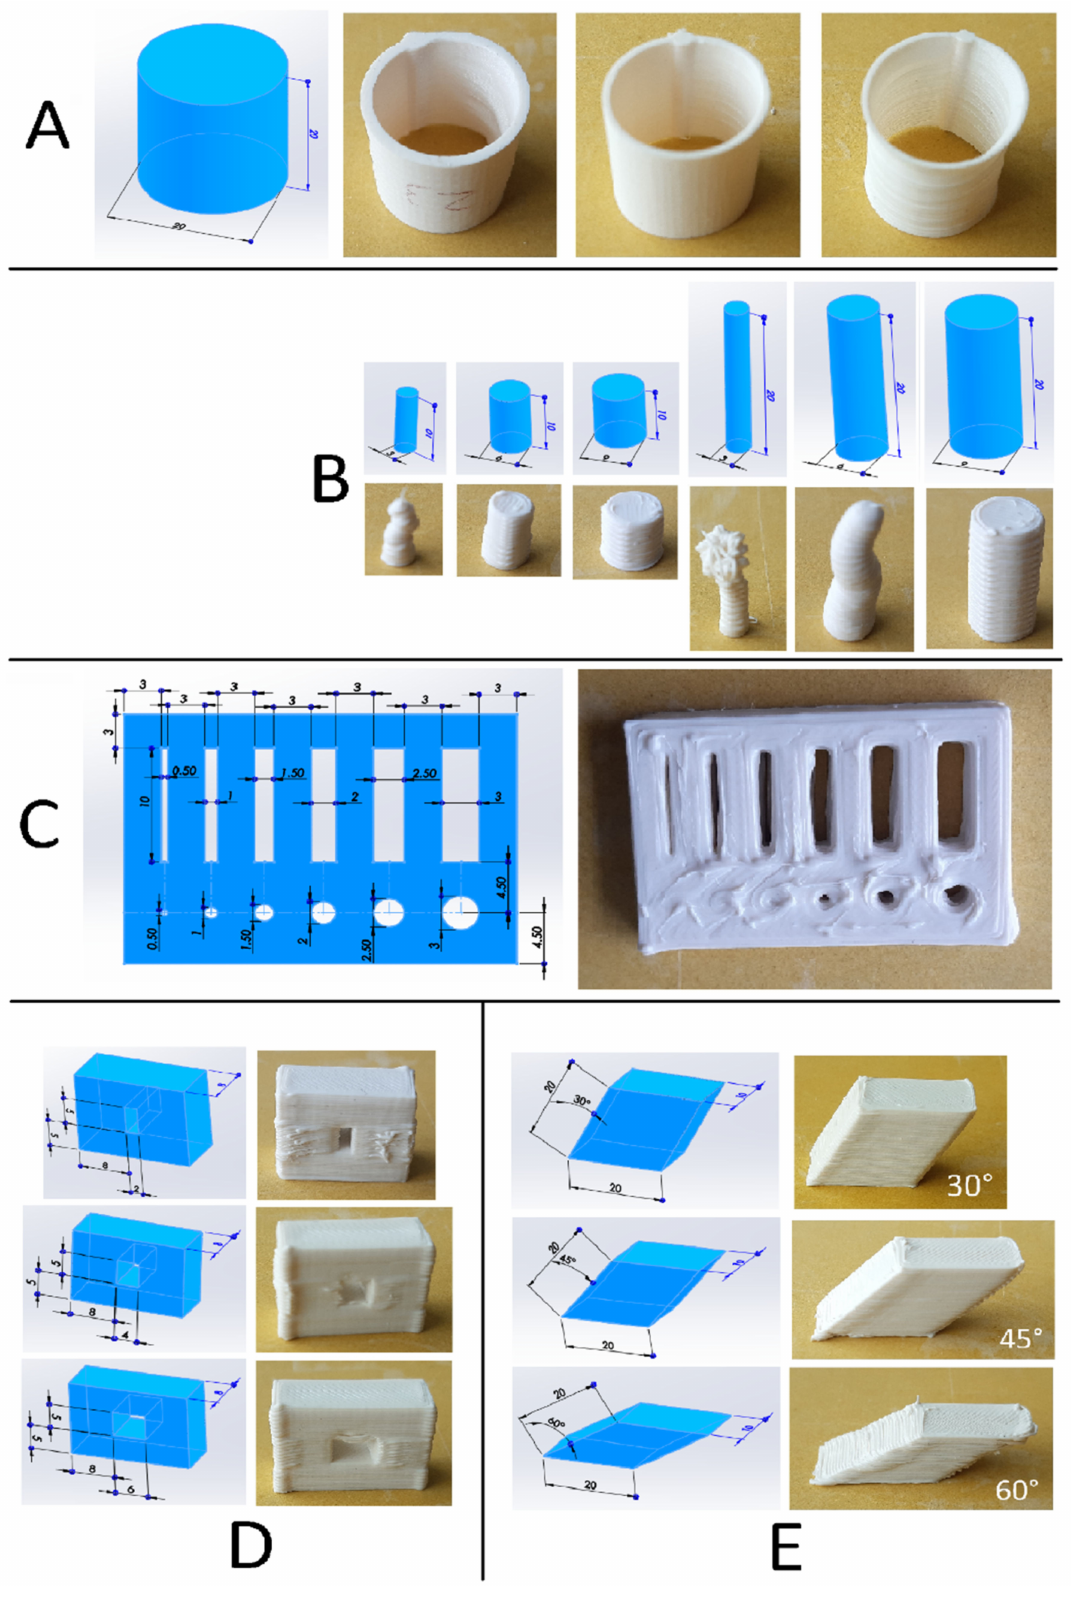
Figure 2. Test objects for the geometric limitation assessment printed from 20102 silicone rubber. The assessed features were ( A ) thin walls; ( B ) tower-like structures; ( C ) holes and slots in the layer plane; ( D ) unsupported bridges; ( E ) unsupported